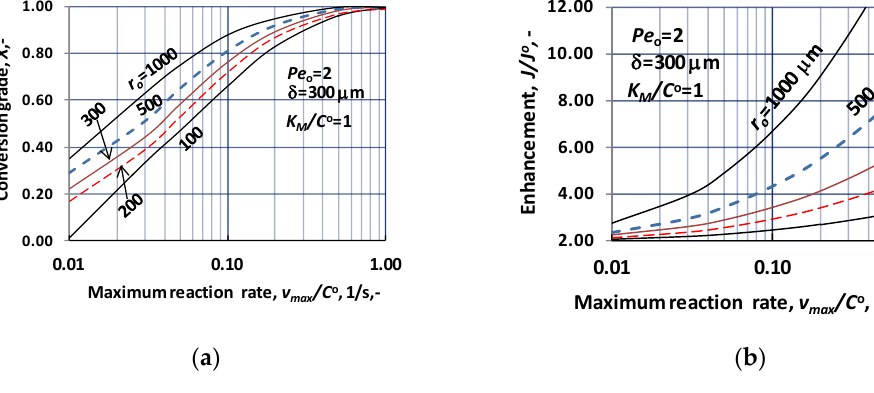
Figure 3. Effect of the v max /C O on the enhancement and on the conversion grade, X, at operating mode without sweeping phase, i.e., d C /d R = 0 at R = R m , applying the Michaelis-Menten kinetics. ( a ) Change of the conversion as a function of the reaction rate, more exactly as a function of v max /C O , at different values of the lumen radius; ( b ) change of the enhancement as a function of the reaction rate ( N = 1000).